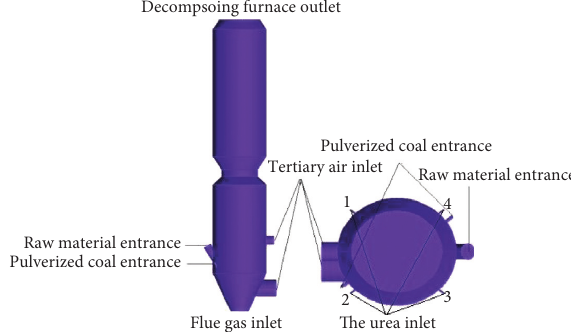
Figure 1: Geometry model of the decomposing furnace.